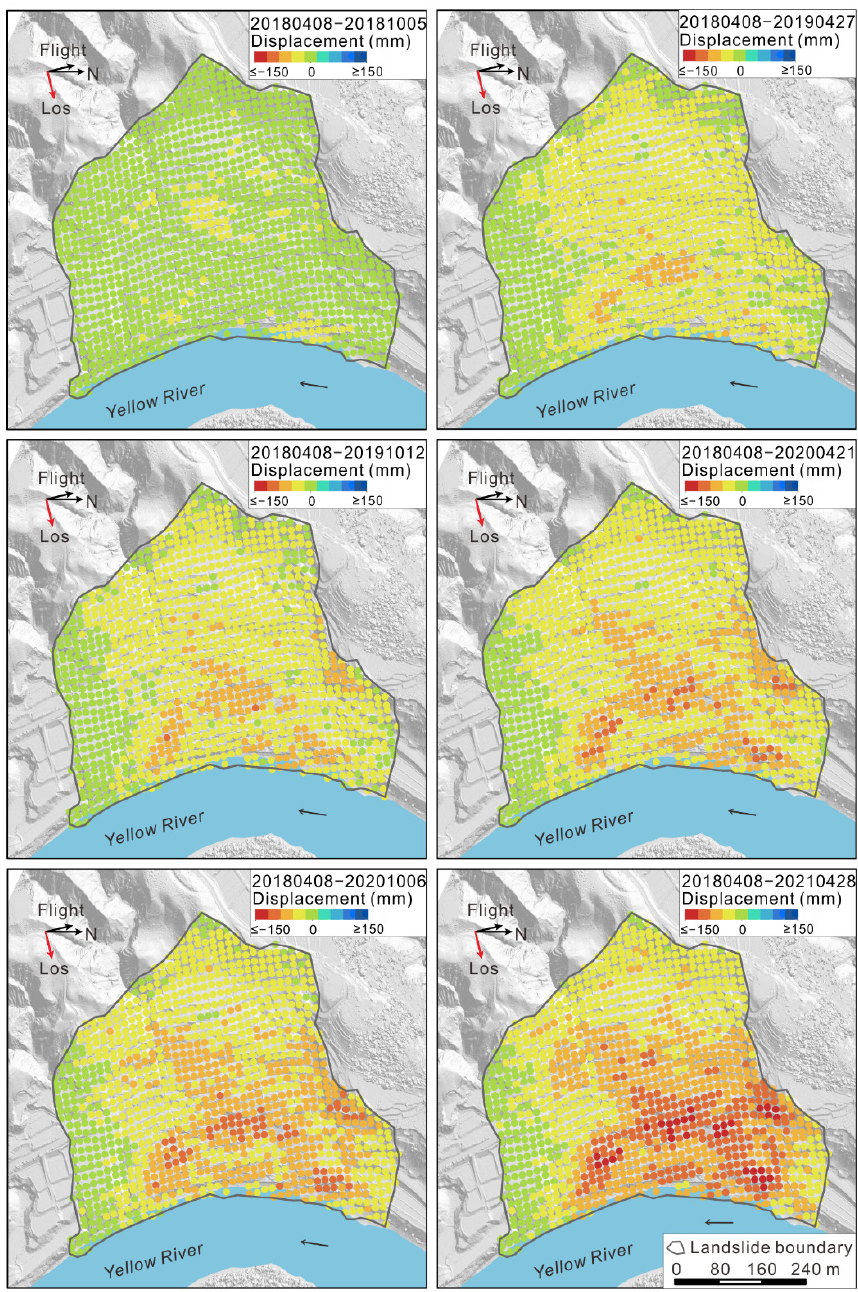
Figure 9. Post-failure cumulative LOS